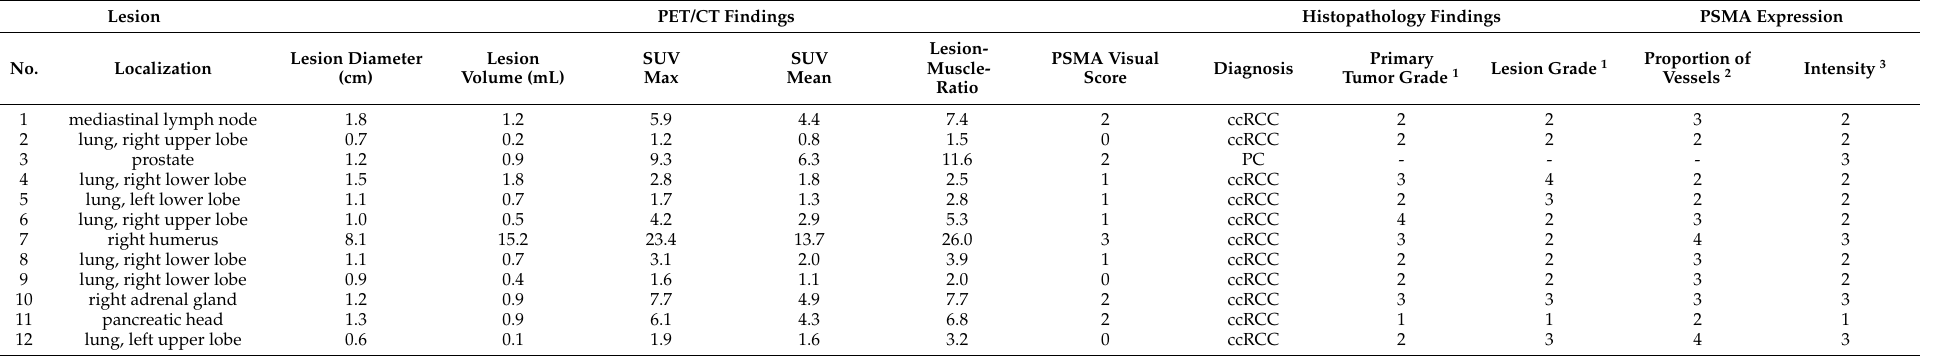
Table 1. Characteristics of histopathologically evaluated